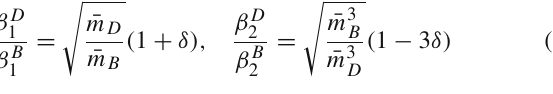
Fig. 8 Fitted ¯ B 0 → π + , ¯ B 0 s → K + (top) and predicted ¯ B − → η (bottom) scalar form factors. Besides the fitted data (UKQCD [20], HPQCD [15,18], FL-MILC [19] and LCSR [12,13]), and for compari- son, predictions from the NLO perturbative QCD approach of Ref. [66] for the ¯ B 0 → π + decay are also shown. Statistical (stat) and statistical plus systematic (stat & sys) 68% – confident level (CL) bands are also